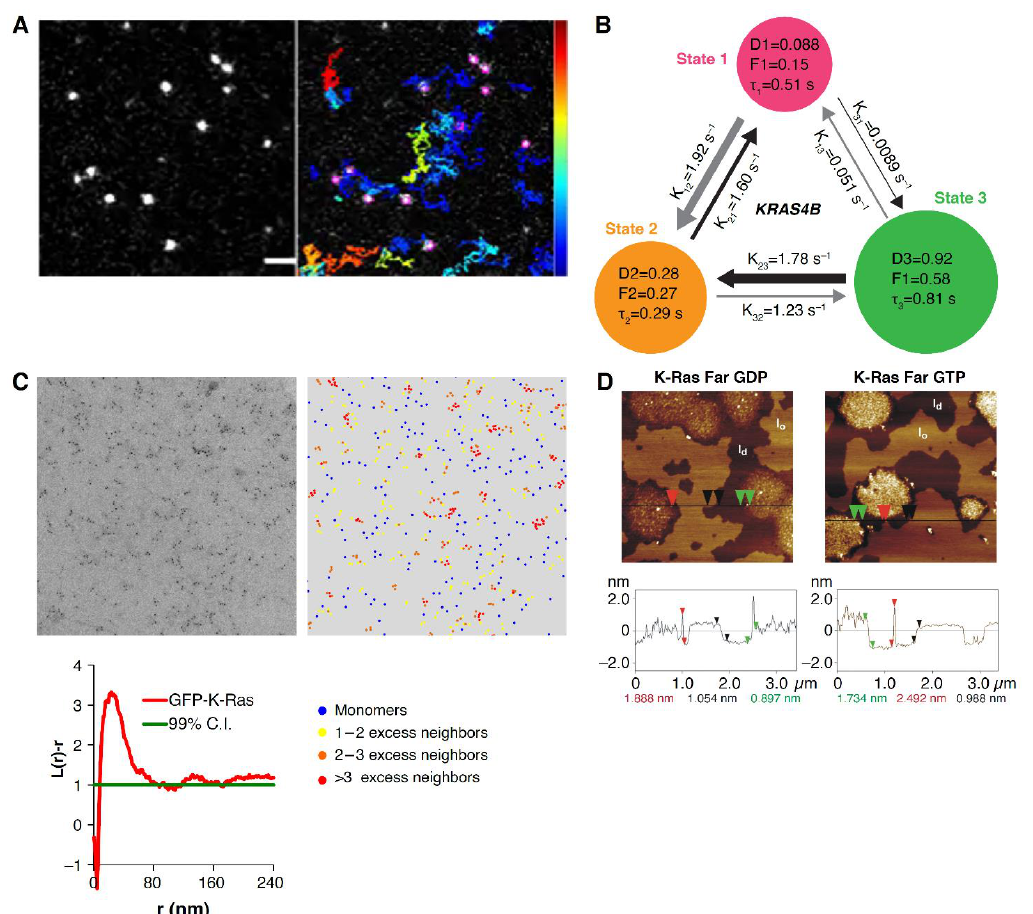
Figure 4. Methods for studying RAS-membrane diffusion behavior and nanocluster formation. ( A ) Single-molecule tracking (SMT) movies of HaloTagged KRAS4b expressed in HeLa cells and labeled with Janelia Fluor 646 dyes. ( B ) Hidden Markov modeling (HMM), using vbSPT analysis [45] of SMT measurements, representing a three-state diffusion model for KRAS4b. ( C ) Electron microscopy images combined with spatial mapping analysis showing KRAS4b nanoclustering in the intact plasma membrane of baby hamster kidney (BHK) cells. ( D ) Atomic force microscopy images of GDP- and GTP-loaded KRAS4b show nucleotide independent nanoclustering of KRAS4b on lipid bilayer composed of DOPC/DOPG/DPPC/DPPG/Chol (20:5:45:5:25). The line graph at the bottom represents the height along the cross section, represented by the black line in the corresponding atomic force microscopy (AFM) images. The arrows represent the vertical distances between pairs of arrows (black, liquid-ordered (Lo)/liquid-disordered (Ld) phase difference; green, thickness difference of the new KRAS4b-enriched domain; and red, size of KRAS4b proteins). Figure 4C reprinted from reference